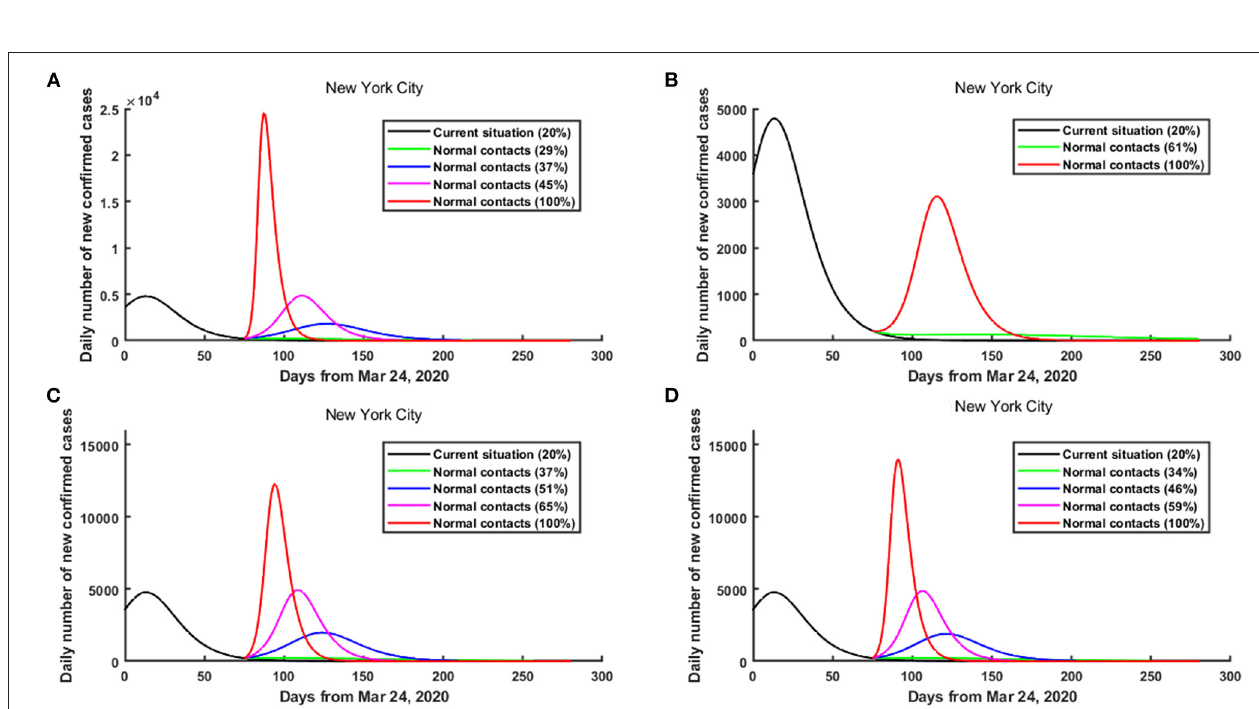
FIGURE 4 | The risk of a second wave of COVID-19 in NYC when different age groups were released from June 8, 2020. (A) All age groups were released. (B) Only 0–17 age group was released. (C) Only 18–44 age group was released. (D) Only 45–64 age group was released.